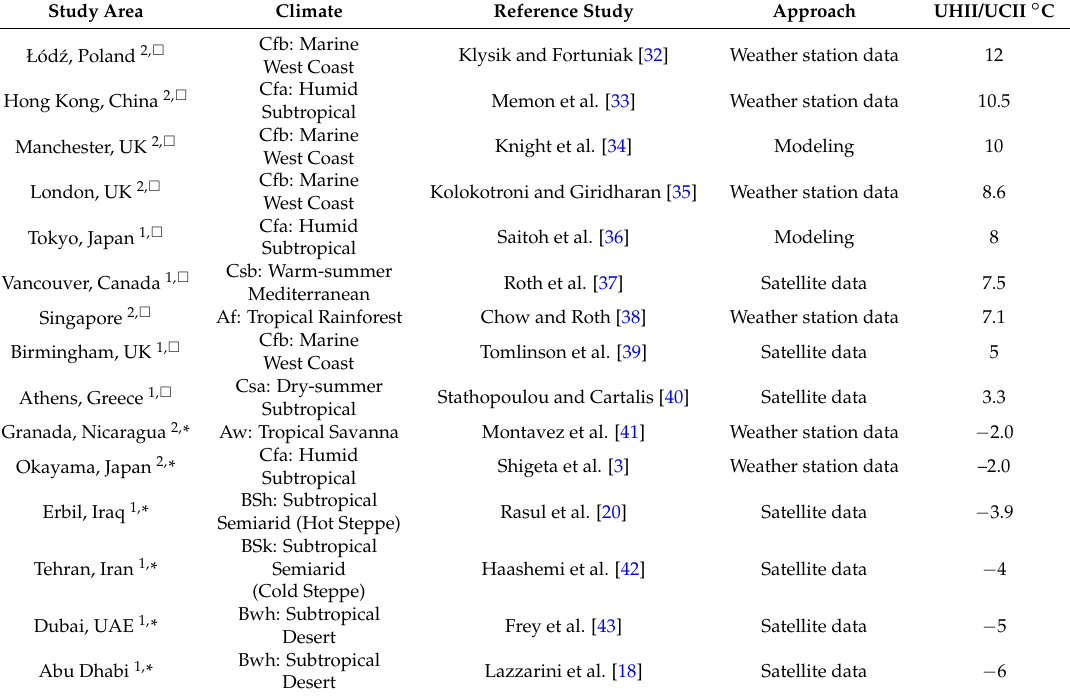
Table 1. A summary of published studies of Urban Heat Island Intensity (UHII)/Urban Cool Island Intensity (UCII) around the